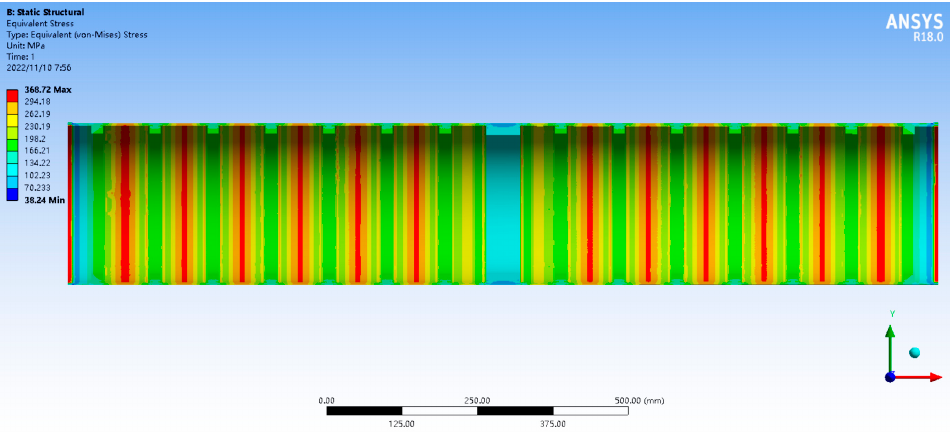
Figure 11. The finite element simulation analysis of the optimized pressure hull.